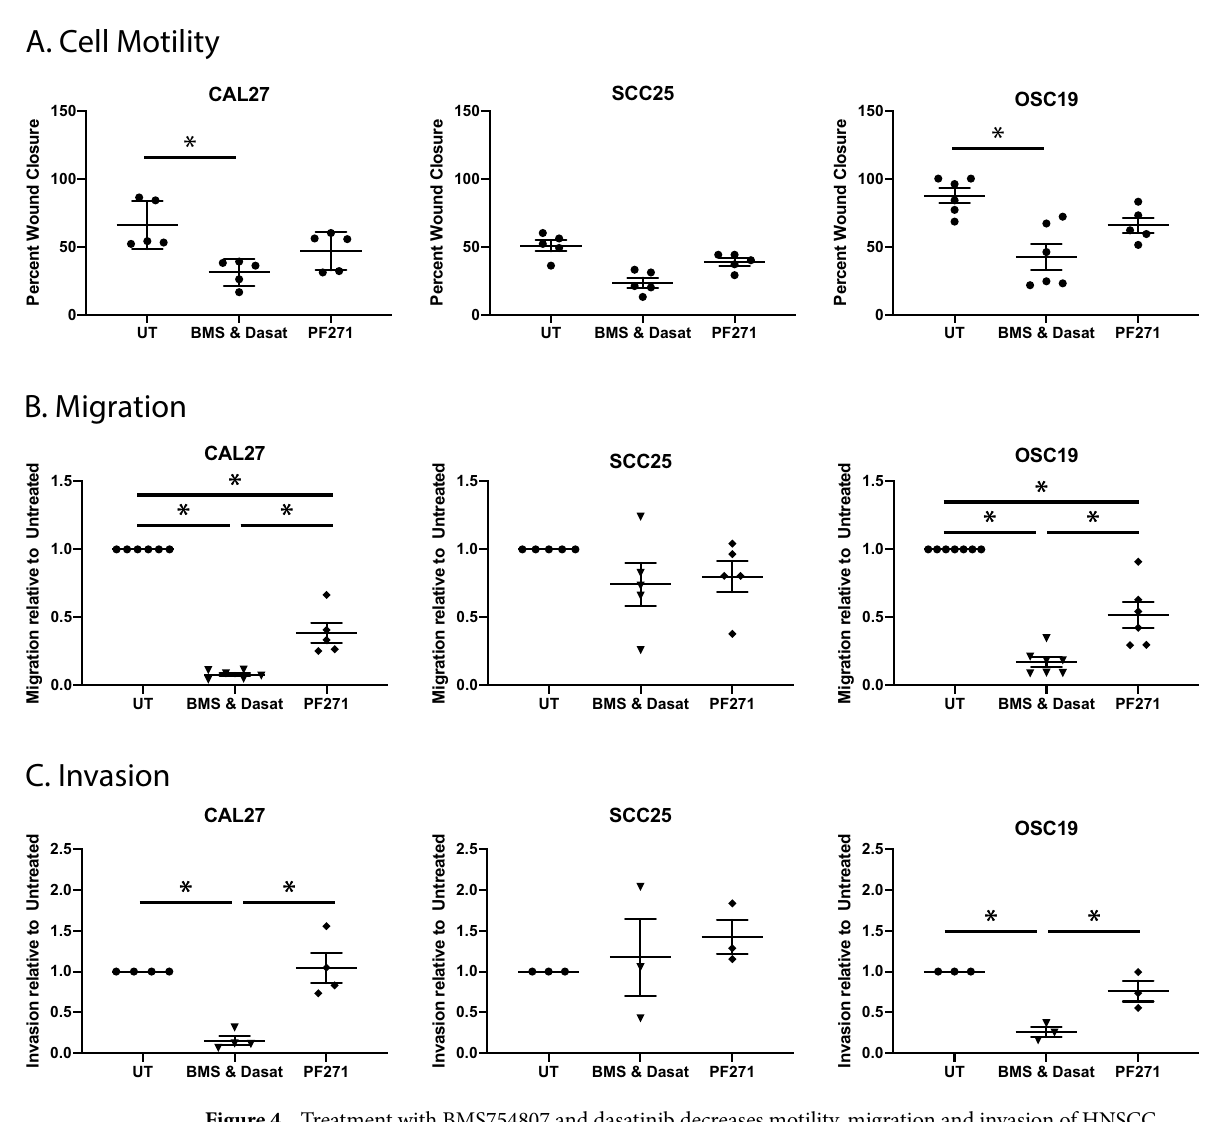
Figure 4. Treatment with BMS754807 and dasatinib decreases motility, migration and invasion of HNSCC. ( A ) Graphs represent mean wound closure ± SEM in each cell line. ( B ) Graphs represent relative migration of cells through a Boyden chamber as compared to untreated cells. ( C ) Relative invasion of HNSCC through a Matrigel-coated Boyden chamber as compared to untreated cells. Quantification by ImageJ. Data is depicted by representation for each independent replicate and the mean ± SEM of at least 5 independent replicates. Asterisks represent p < 0.05 as determined by one-way ANOVA and Tukey post-hoc